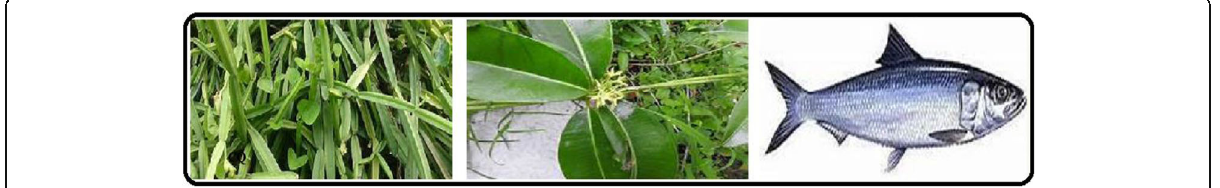
Fig. 1 Images of Cissus quadrangularis (CQ), Cryptolepis buchanani (CB), and Sardinella Longiceps